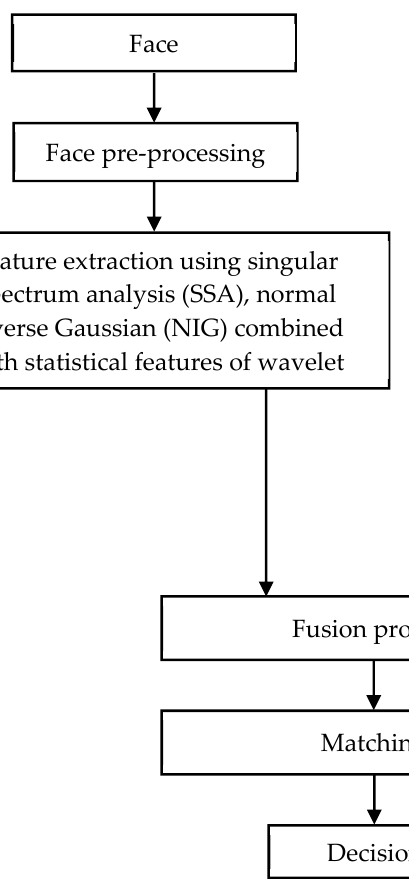
Figure 3. Iris segmentation and normalization. (